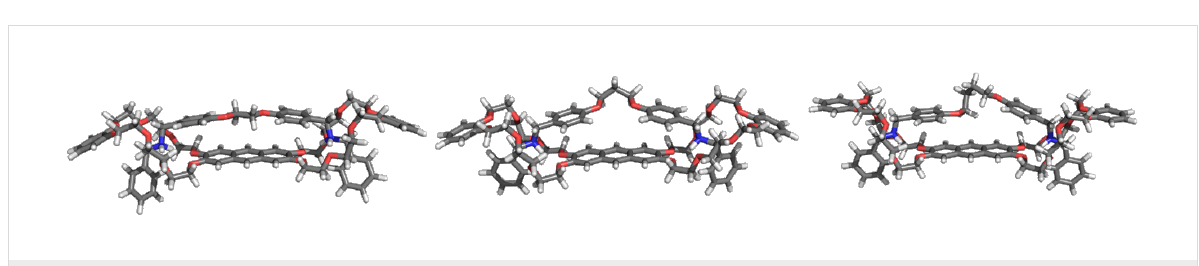
Figure 2: Optimized gas phase structures (TPSS-D3(BJ)/def2-TZVP) of the divalent complexes n 0 @DiC8, n 1 @DiC8 and n 2 @DiC8.